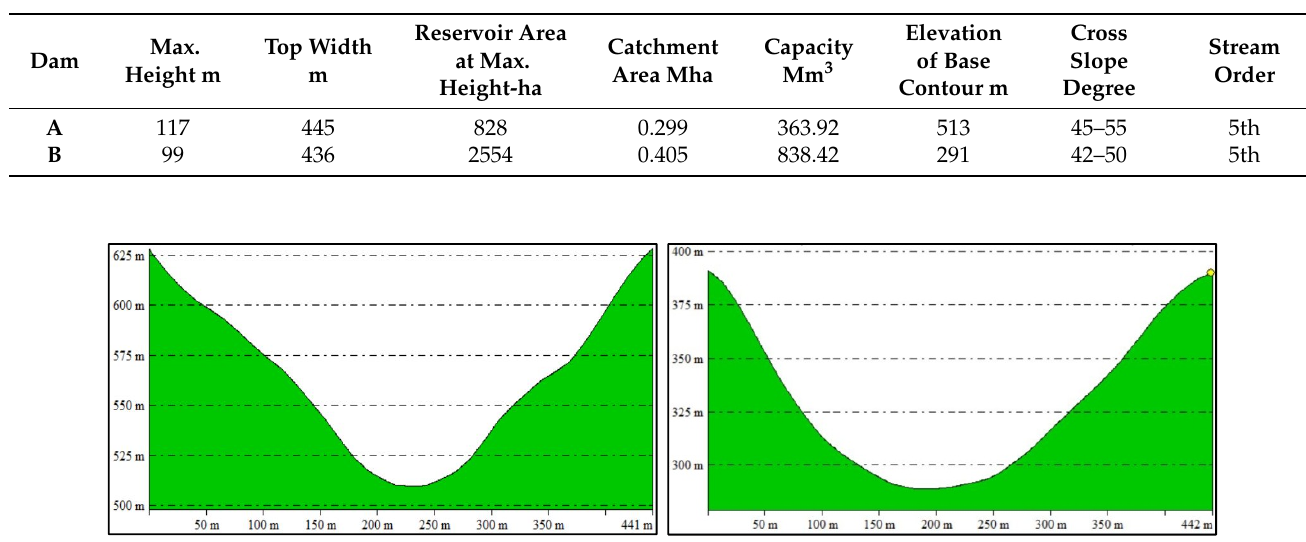
Figure 4. Indicator values for selected sites. Table 6. Summary of selected suitable sites.